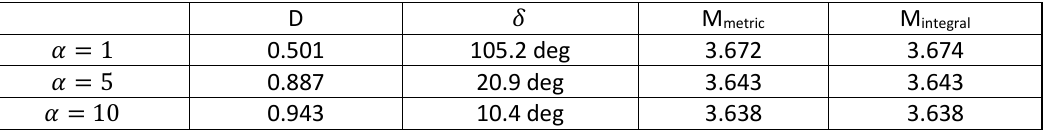
Table 2 . The quantity D is where the metric function A ( r ) plateaus to asymptotically and δ is the angular deficit quoted in degrees and evaluated using (3.6). The mass M metric is obtained using the metric and calculated via (3.5) and M integral is evaluated via (3.9) as an integral over the matter profiles. The two masses should match and they do. The angular deficit has a strong dependence on α : it basically increases tenfold from α = 10 to α = 1 . In contrast, the mass of the vortex hardly changes with α and is not very different from the mass in the no gravity